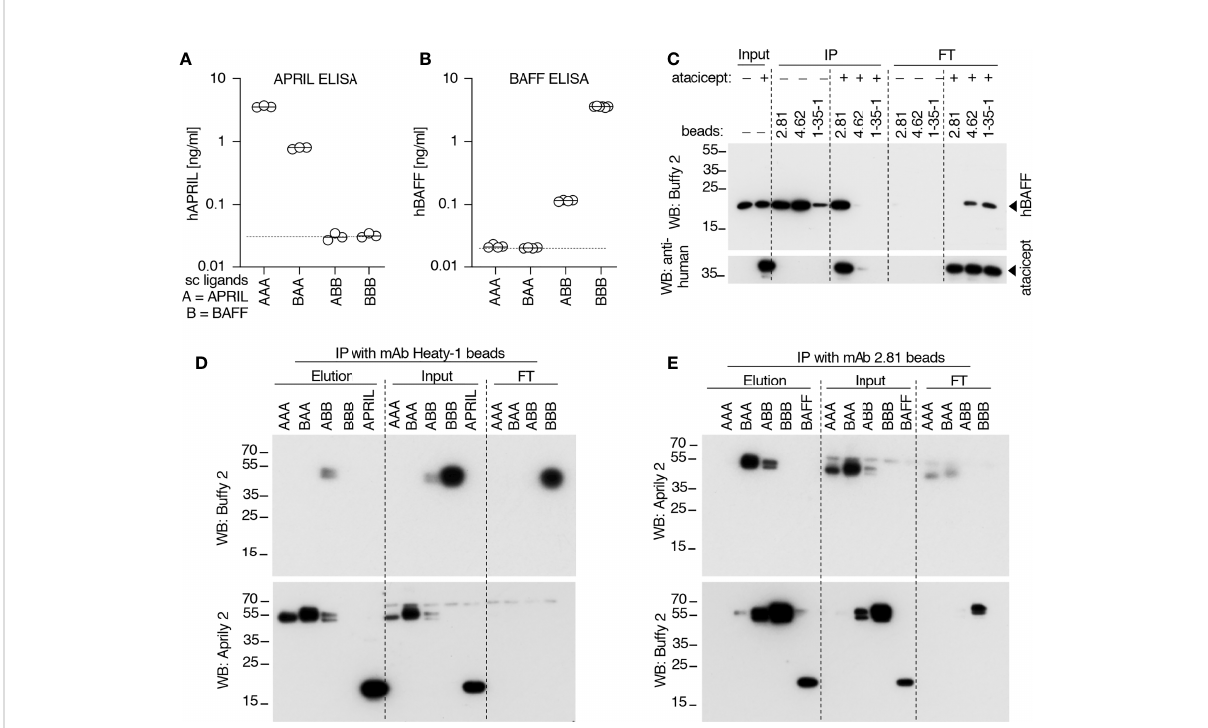
FIGURE 7 Detection and immunoprecipitation of recombinant BAFF and APRIL heteromers. (A, B) The recognition of recombinant Fc-tagged single chain BAFF, APRIL and heteromers was tested in APRIL and BAFF ELISAs. Experiment performed twice. (C) Different anti-BAFF mAbs were coupled to beads and used to immuno-precipitate recombinant Flag-BAFF (100 ng) in the presence or absence of atacicept (1000 ng). Immuno- precipitates were analyzed by SDS-PAGE and Western blot anti-BAFF to detect BAFF, followed by anti-human IgG to detect atacicept. Experiment performed three times. (D) Single chain recombinant BAFF, APRIL or their heteromers, or Flag-APRIL, were immune-precipitated with beads-coupled anti-APRIL mAb Heaty-1. Immuno-precipitates were analyzed by Western blots anti-APRIL and anti-BAFF. (E) Same as panel D, except beads coupled to anti-BAFF mAb 2.81 were used for the immune-precipitation and Flag-BAFF was used as positive control. Experiment was performed